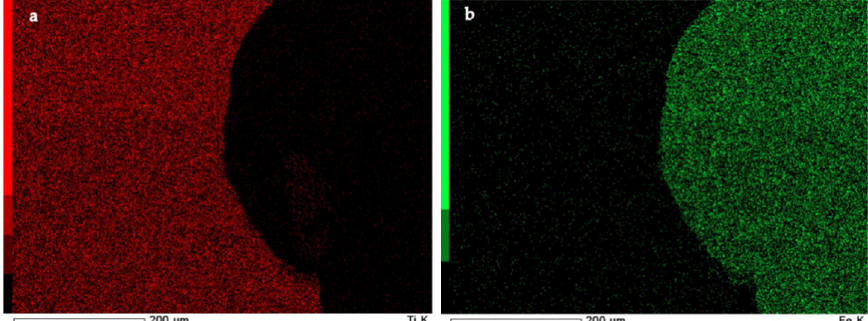
Figure 5. Ti and Fe elements maps at low magnification (Figure 3a): ( a ) Ti element map; ( b ) Fe element map.